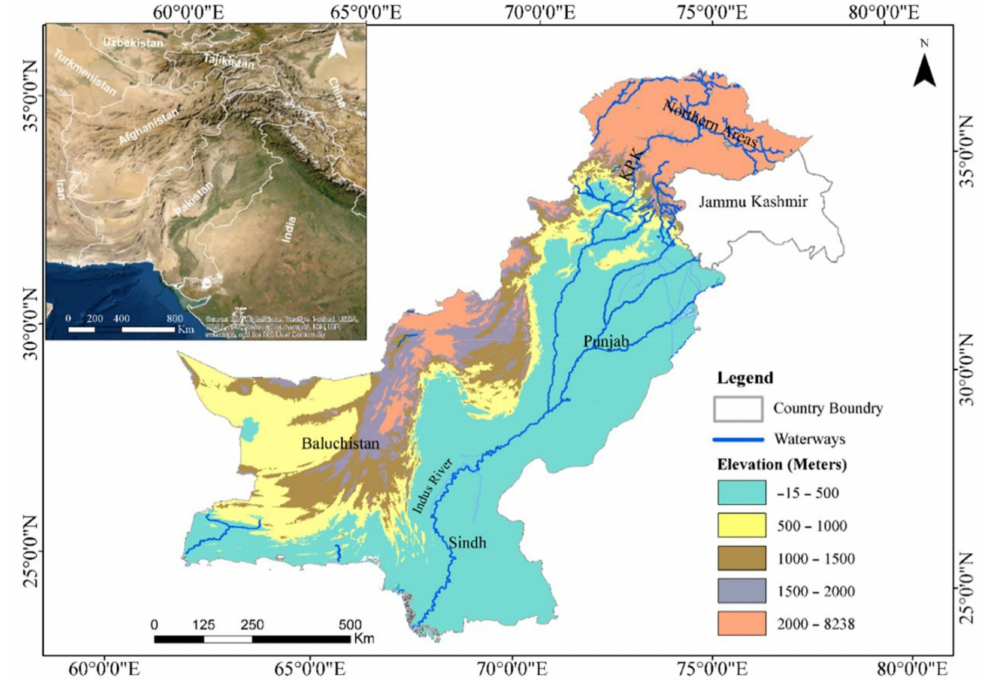
Figure 1. Location of the Indus River within Pakistan. Pakistan’s topography borders with Afghanistan, India, and Iran are presented in the